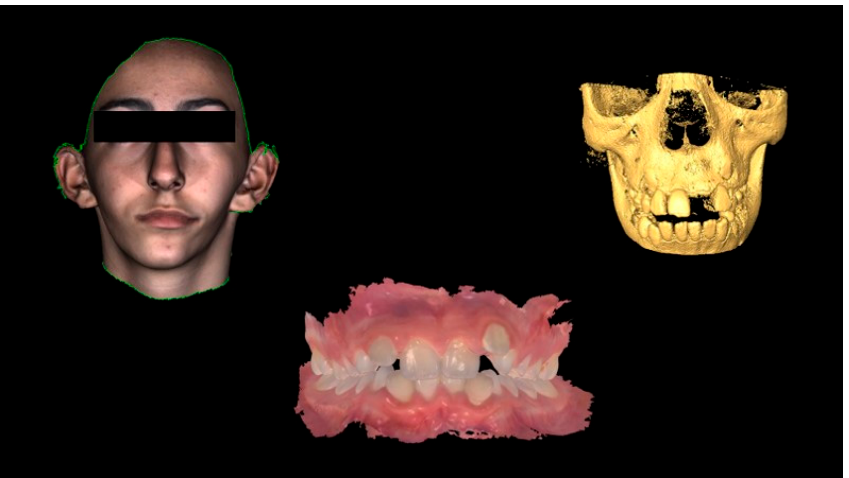
Figure 1. The three ‐ dimensional workflow (from left to right): 3D image of the face, intraoral Figure 1. The three-dimensional workflow (from left to right): 3D image of the face, intraoral impression impression of the dentition and cone ‐ beam computed tomography (CBCT) scan of the skeleton. of the dentition and cone-beam computed tomography (CBCT) scan of the